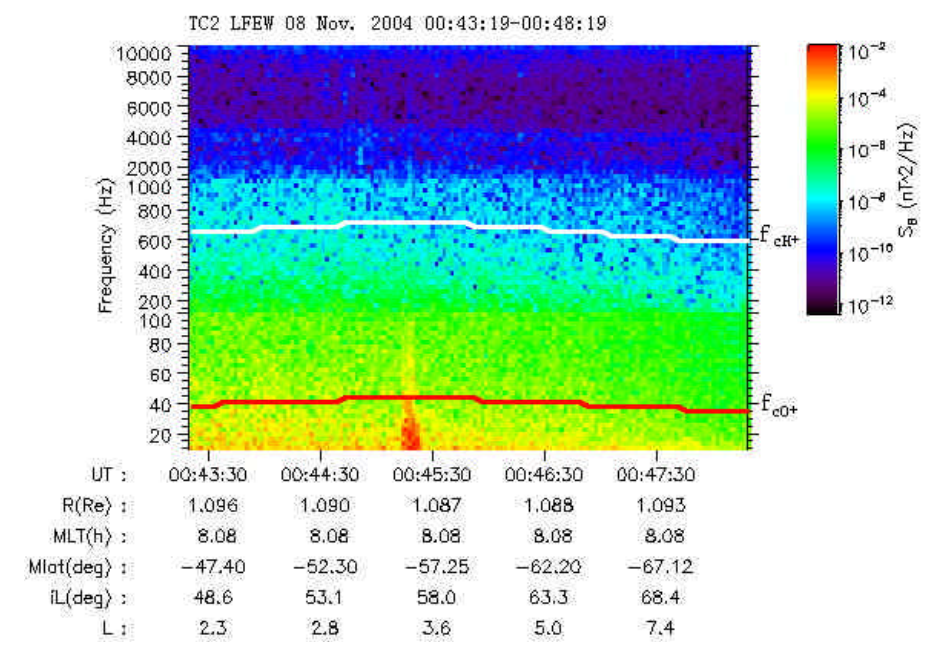
Fig. 5 The time-frequency spectrum observed by LFEW at 00:43:15-00:48:15 on Nov.8 2004 Fig. 5. The time-frequency spectrum observed by LFEW at 00:43:15–00:48:15UT on 8 November 2004.